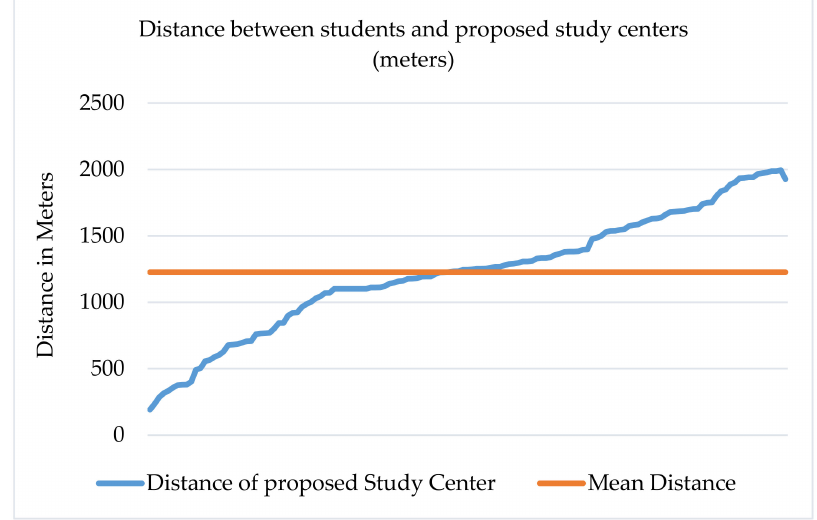
Figure 7. Distances between students and study centers, and mean distance (meters).